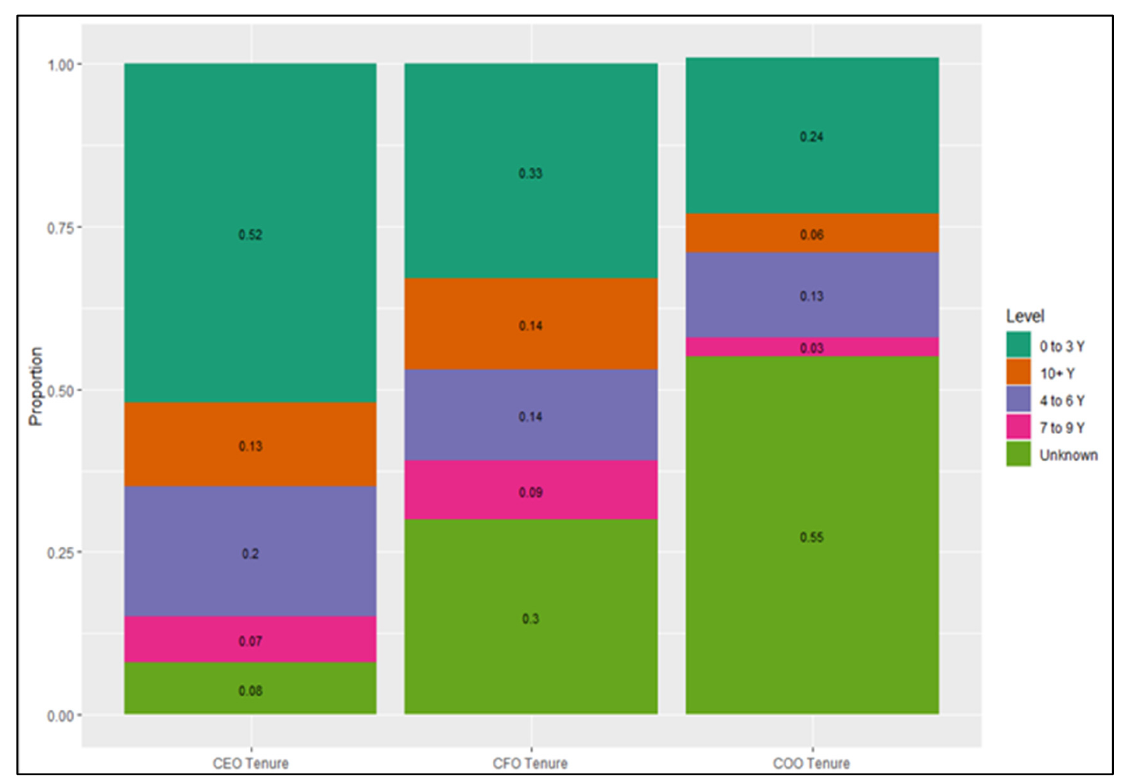
Figure 3. Tenure status for C-Staff.